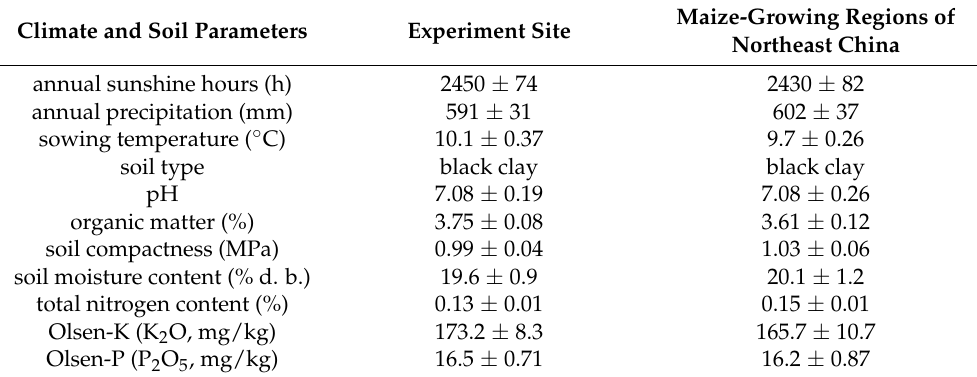
Figure 2. Experimental site selection and experimental area division: ( a ). schematic diagram of experimental area division and top view of the ground surface after the experiment, ( b ). schematic diagram of experimental site location. Table 2. Comparison of straw crushing length and bionic fine-crush straw mechanism operating parameters. Climate and Soil Parameters